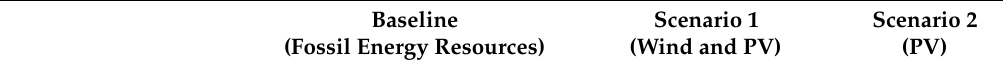
Table 4. Capacities and annual costs of the electricity supply energy system and the synthetic fuel production plant, in addition the revenues from surplus electricity